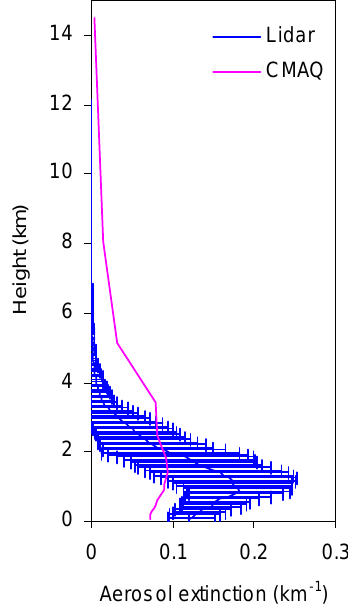
Fig. 8. Vertical distribution of aerosol extinction (km − 1 ) from both Lidar and CMAQ model at Phimai in Thailand (15.19 ◦ N, 102.56 ◦ E). One standard deviation of Lidar measured aerosol ex- Figure 8. Vertical distribution of aerosol extinction (km -1 ) from both Lidar and CMAQ model at tinction was shown at interval height of every Phimai in Thailand (15.19 °N, 102.56°E ). One standard deviation of Lidar measured aerosol extinction was shown at interval height of every 75 m.